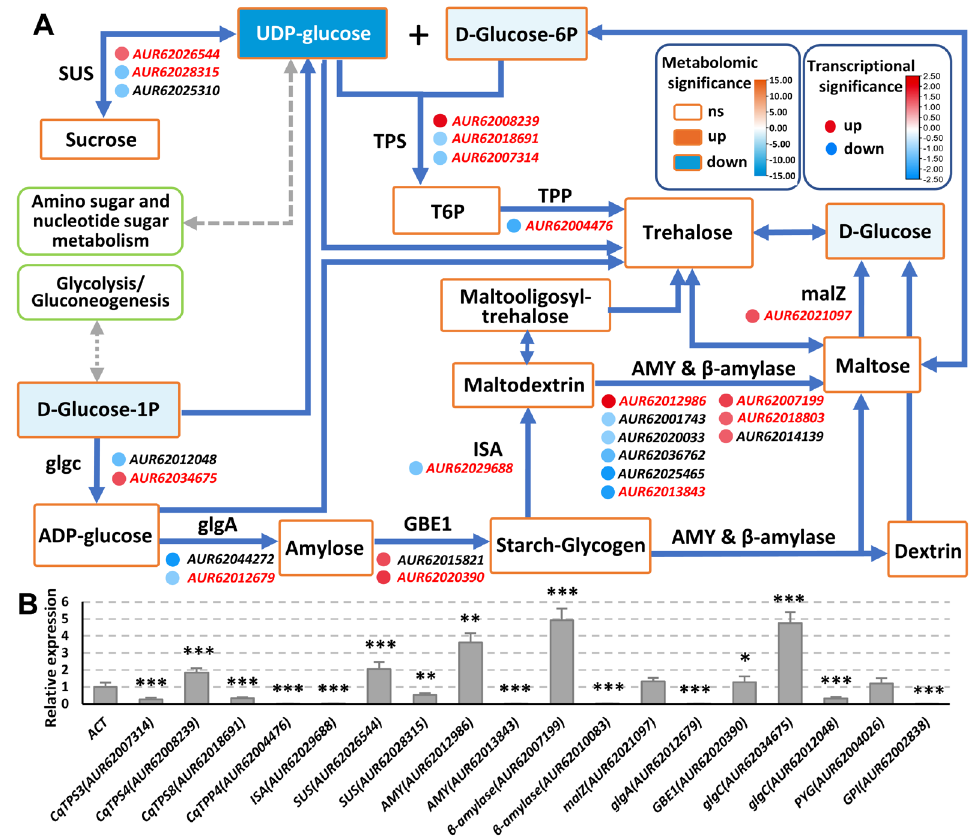
Figure 5. GO Analysis of starch and sucrose metabolism (main routes related to trehalose metabolism) in quinoa leaves. ( A ) Overview of the starch and sucrose metabolism pathway in quinoa leaves in response to saline-alkali stress. Rectangles with orange frames, metabolites; circles, DEGs; blue solid lines with arrows, directions of the processes; rectangles with green frames, other metabolism pathways; gray dotted lines, connection of the starch and sucrose metabolism pathway with other metabolism pathways. The colors of rectangles and circles indicate significances, which are presented in color scales. The genes highlighted in red were detected by RT-qPCR. ( B ) RT-qPCR analysis of the DEGs. UBQ9 (AUR62020068) was used as endogenoue control. Three independent experiments per sample, three replicates per experiment. *, p < 0.05; **, p < 0.01; ***, p < 0.001; Student’s